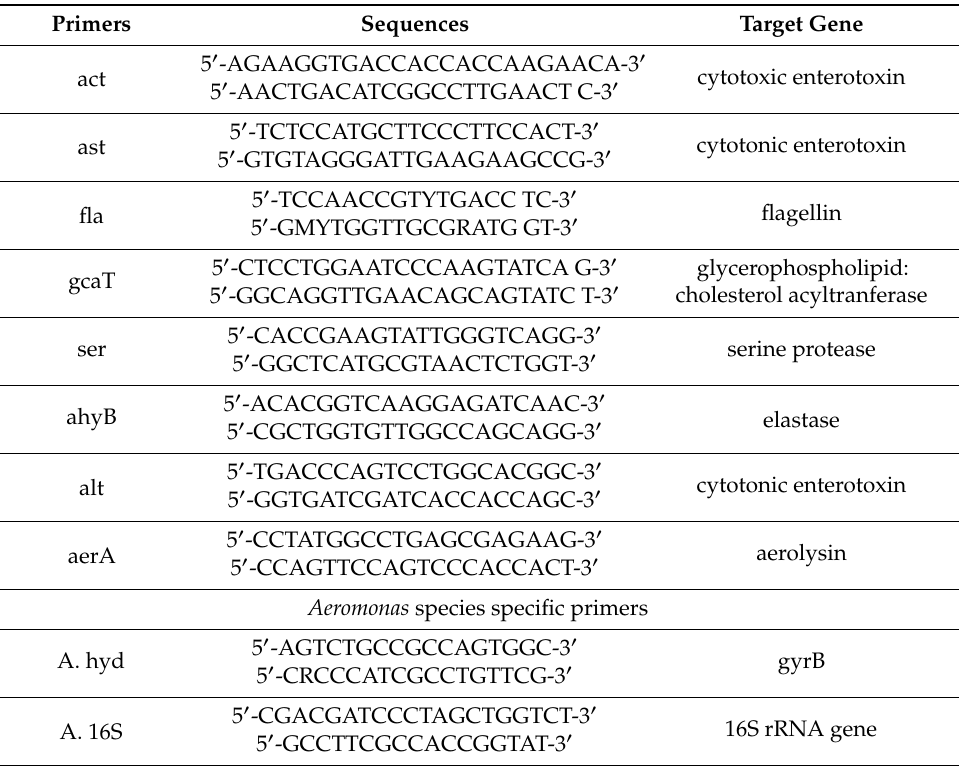
Table 1. Primers used in this study.